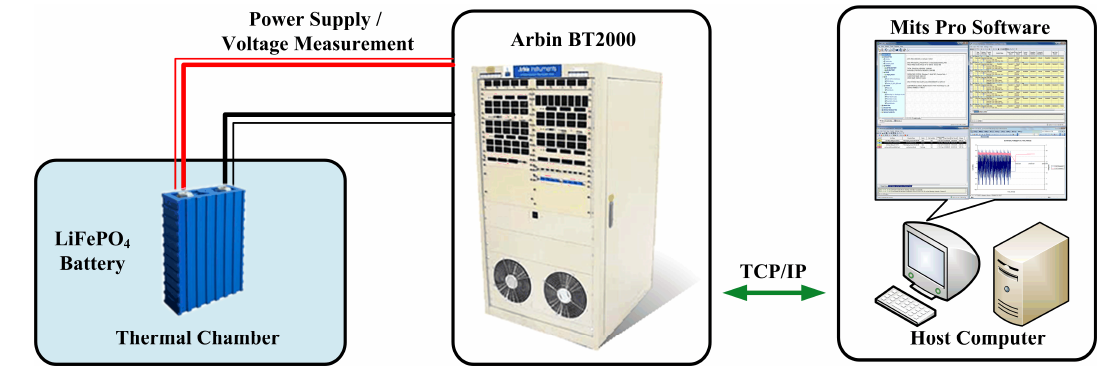
Figure 1. Schematic of the battery test